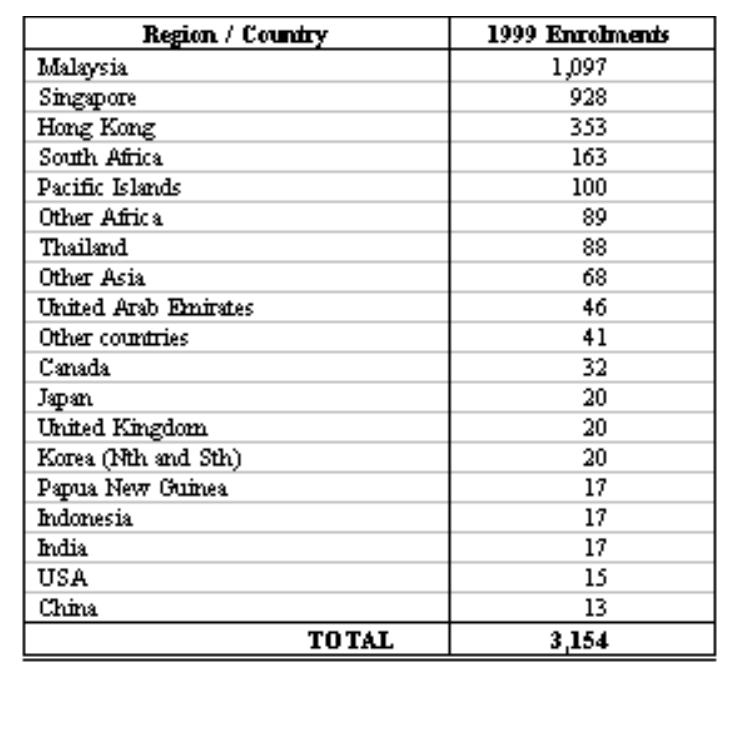
Table 3: USQ’s International Students Offshore in 1999